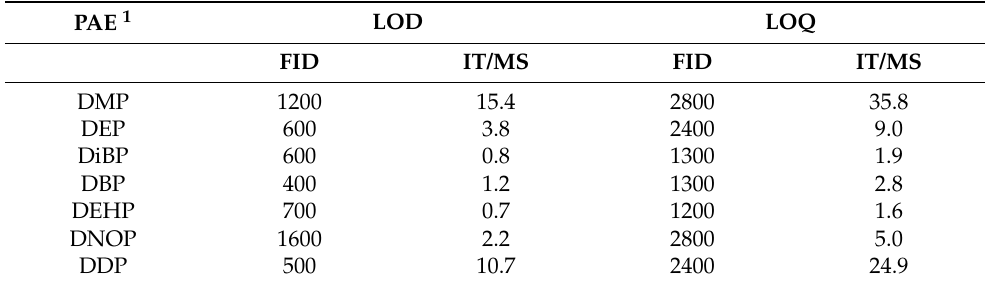
Table 7. Comparison between limit of detection (LOD, ng mL − 1 ) and limit of quantification (LOQ, ng mL − 1 ) of each PAE investigated in this study by UVA-DLLME followed by GC-FID and GC-IT/MS